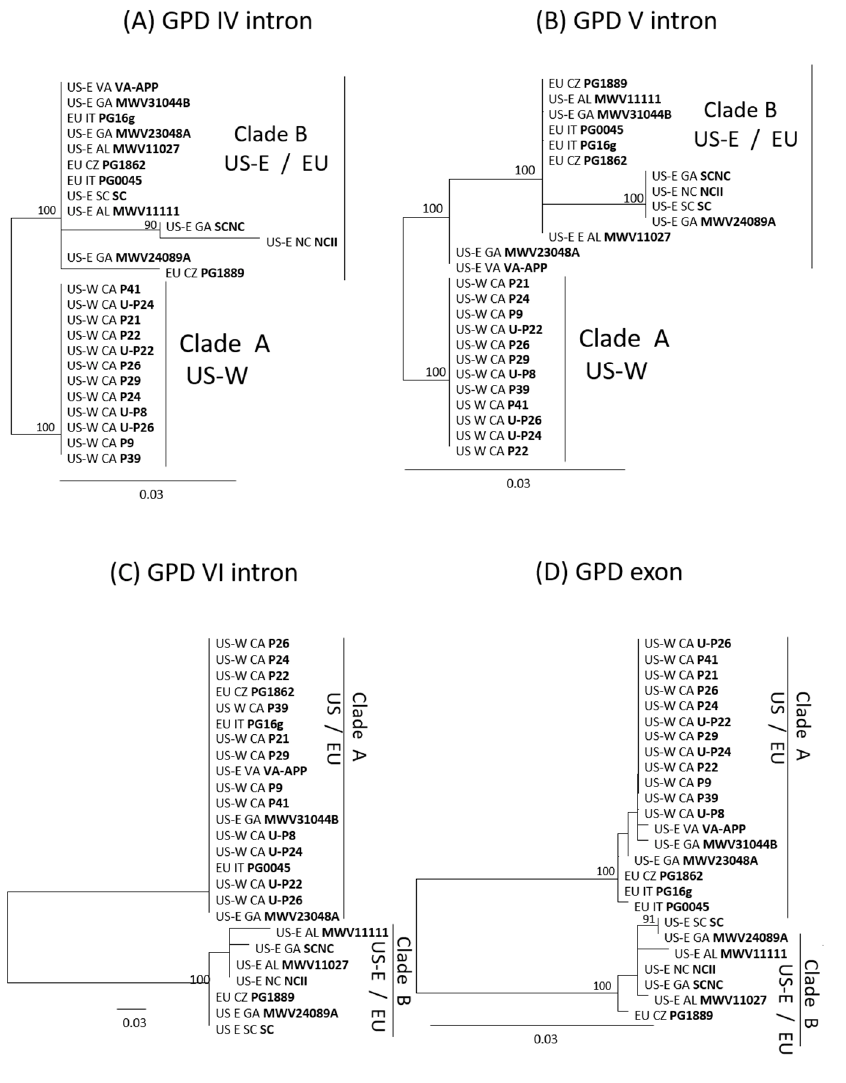
Figure 9. Maximum likelihood phylogram obtained from ( A ) IV intron of GPD ; ( B ) V intron of GPD ; ( C ) VI intron of GPD ; ( D ) partial exon of GPD. ML bootstrap percentages ≥ 70% are given above each clade. Labels indicate: geographic area, state, isolate code.